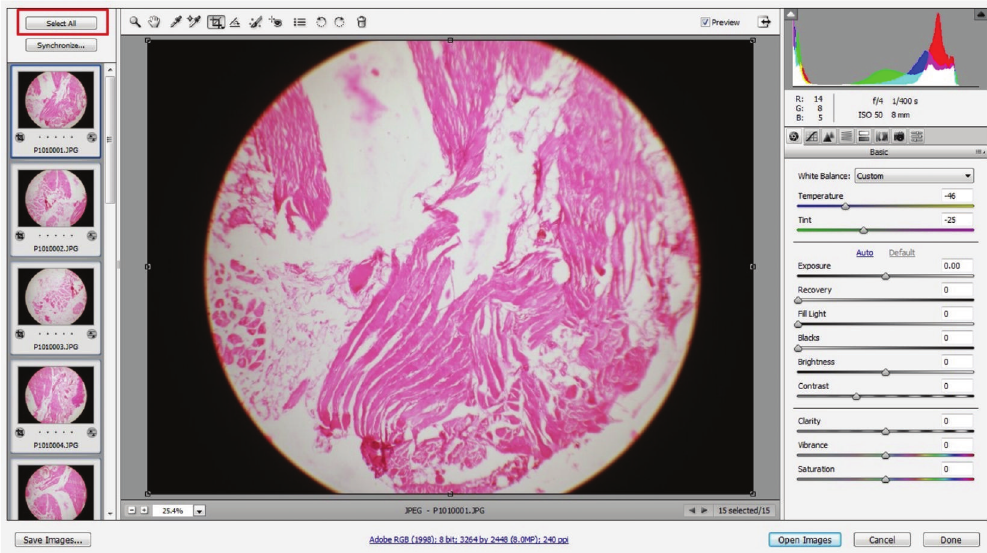
Figure 4: All photomicrographs opened in ACR window of Adobe Photoshop through Adobe Bridge. Note: select all to apply image optimizing settings to all images instantaneously. Note the red boxes in the figure. Follow them for an easy workflow.